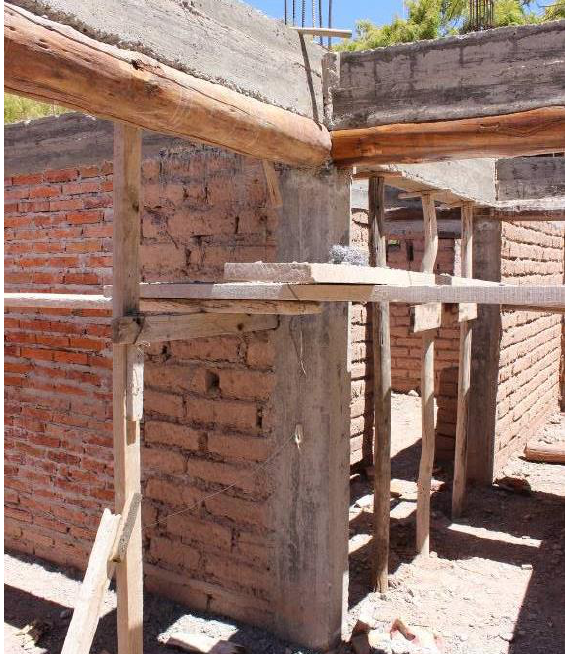
Figure 8. Stone finishing in a house in Tilcara ©